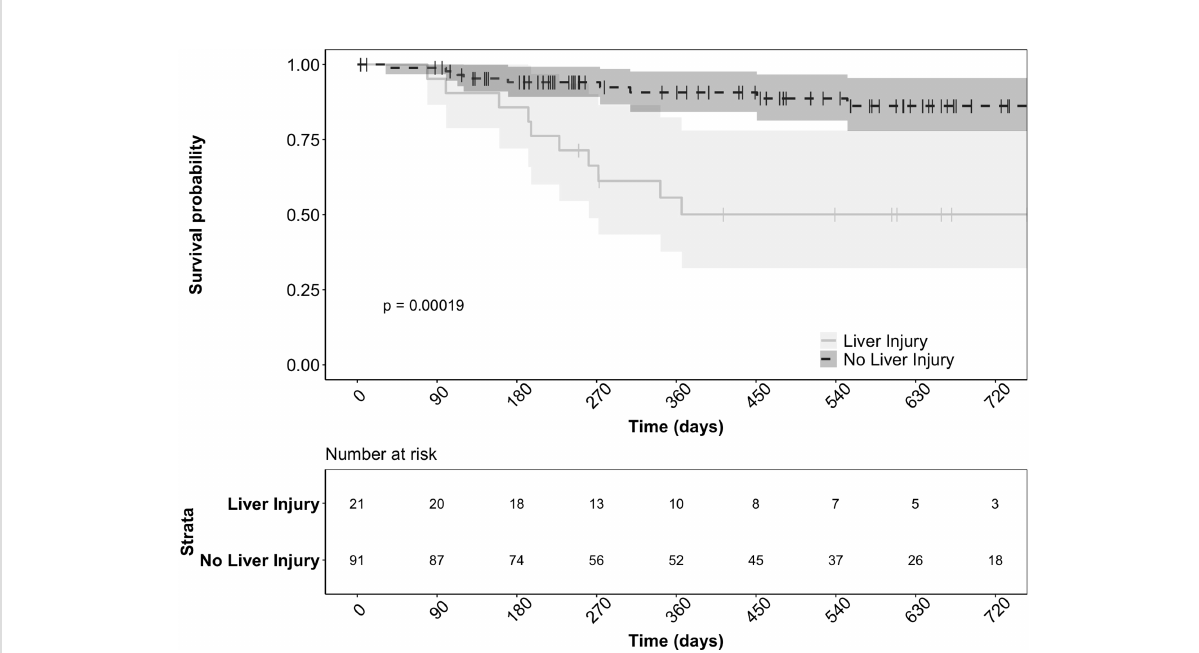
FIGURE 2 Survival of patients with and without liver injury after starting durvalumab based immunotherapy. The actuarial patient survival of the 21 patients who developed liver injury was signi fi cantly lower than those without liver injury ( p = < 0.001 Kaplan ‐ Meier